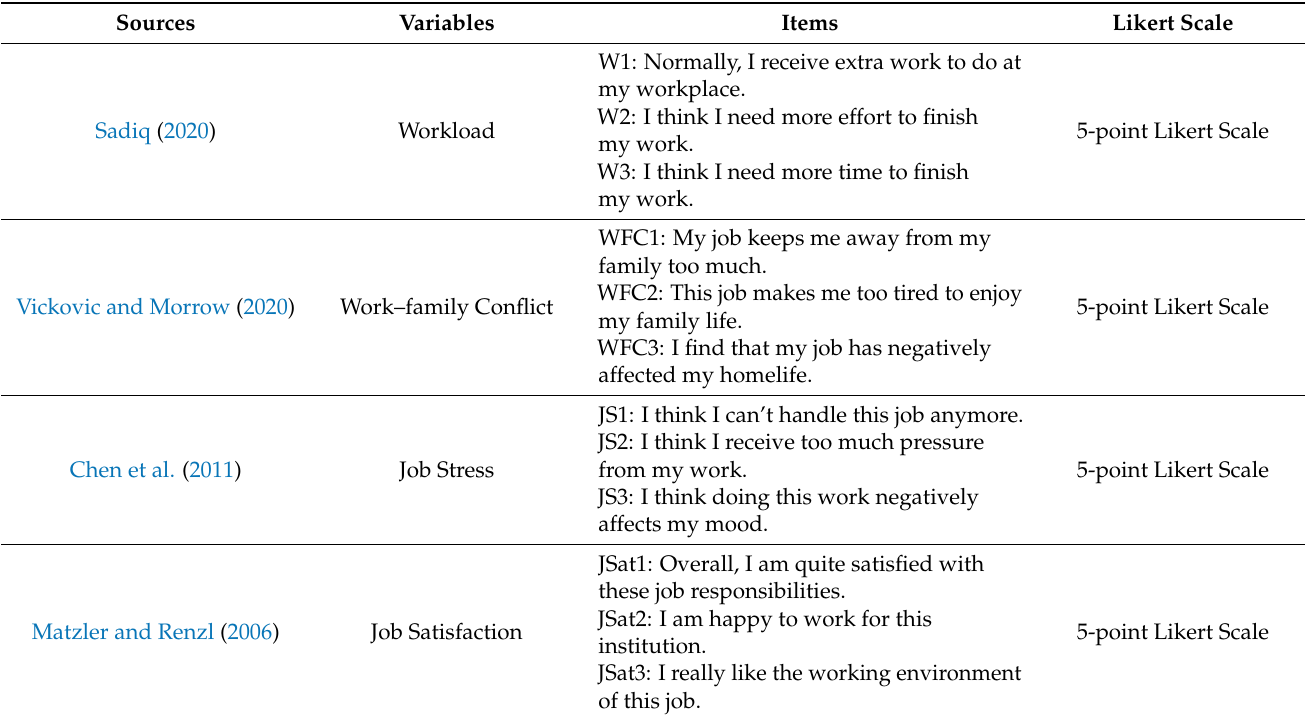
Table 1. Measurement and Likert